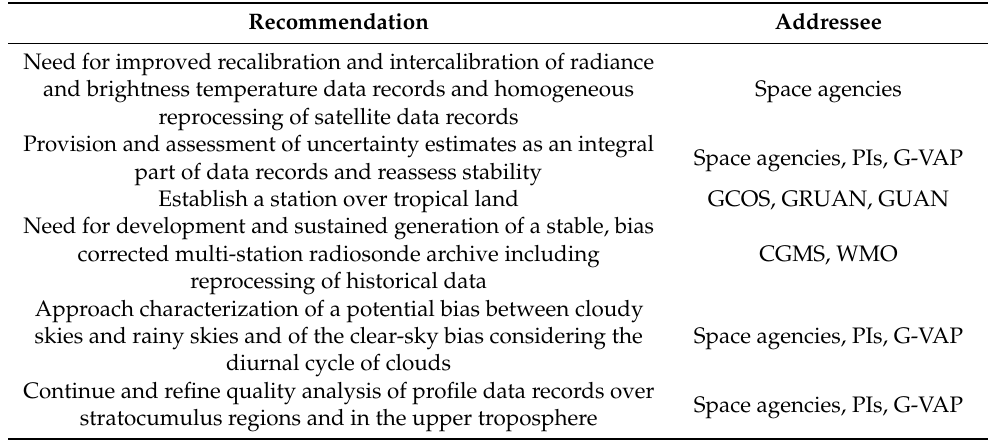
Table 6. Recommendations from G-VAP. More recommendations are given in